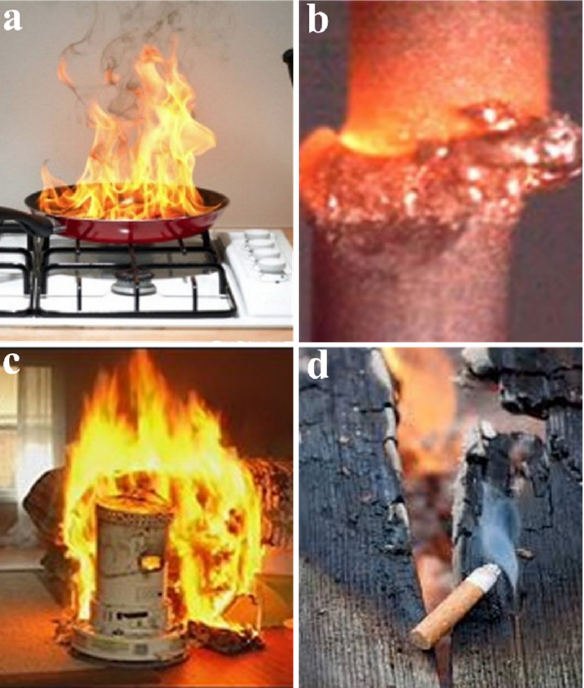
Figure 1. Causes of fires in structures: ( a ) cooking equipment fires, ( b ) glowing electrical wire connections, ( c ) space heater fires, ( d ) fire from a cigarettes. There are other causes of fire in buildings, such as vandalism, fireworks, failure to maintain fire protection systems in buildings, etc. All these factors can either cause the fire or increase its intensity and hinder the activities of firefighters in